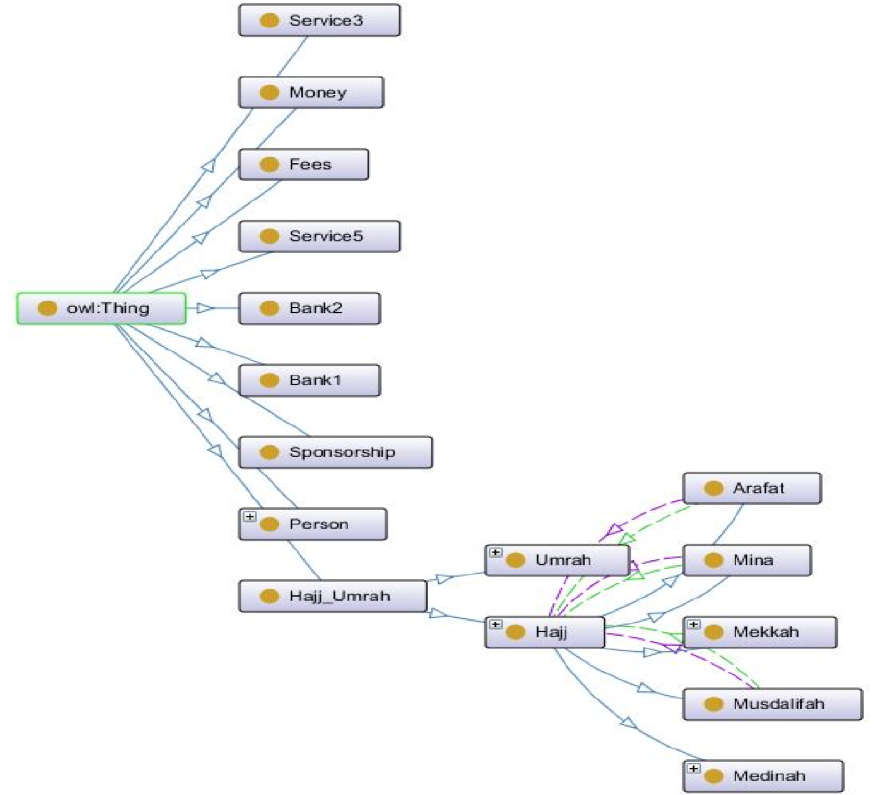
Figure 7. Part of ontology development in